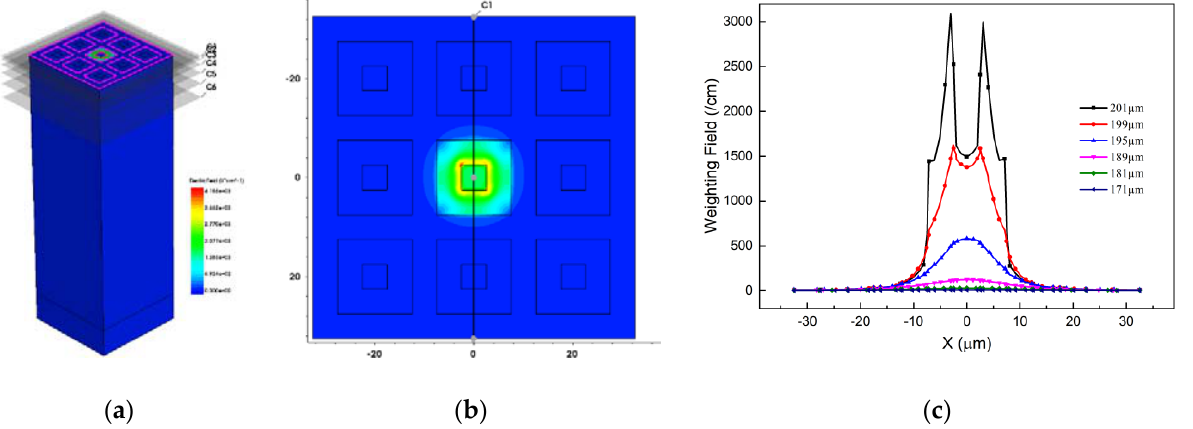
Figure 7. The ( a ) 3D; ( b ) 2D; and ( c ) 1D weighting field distribution.